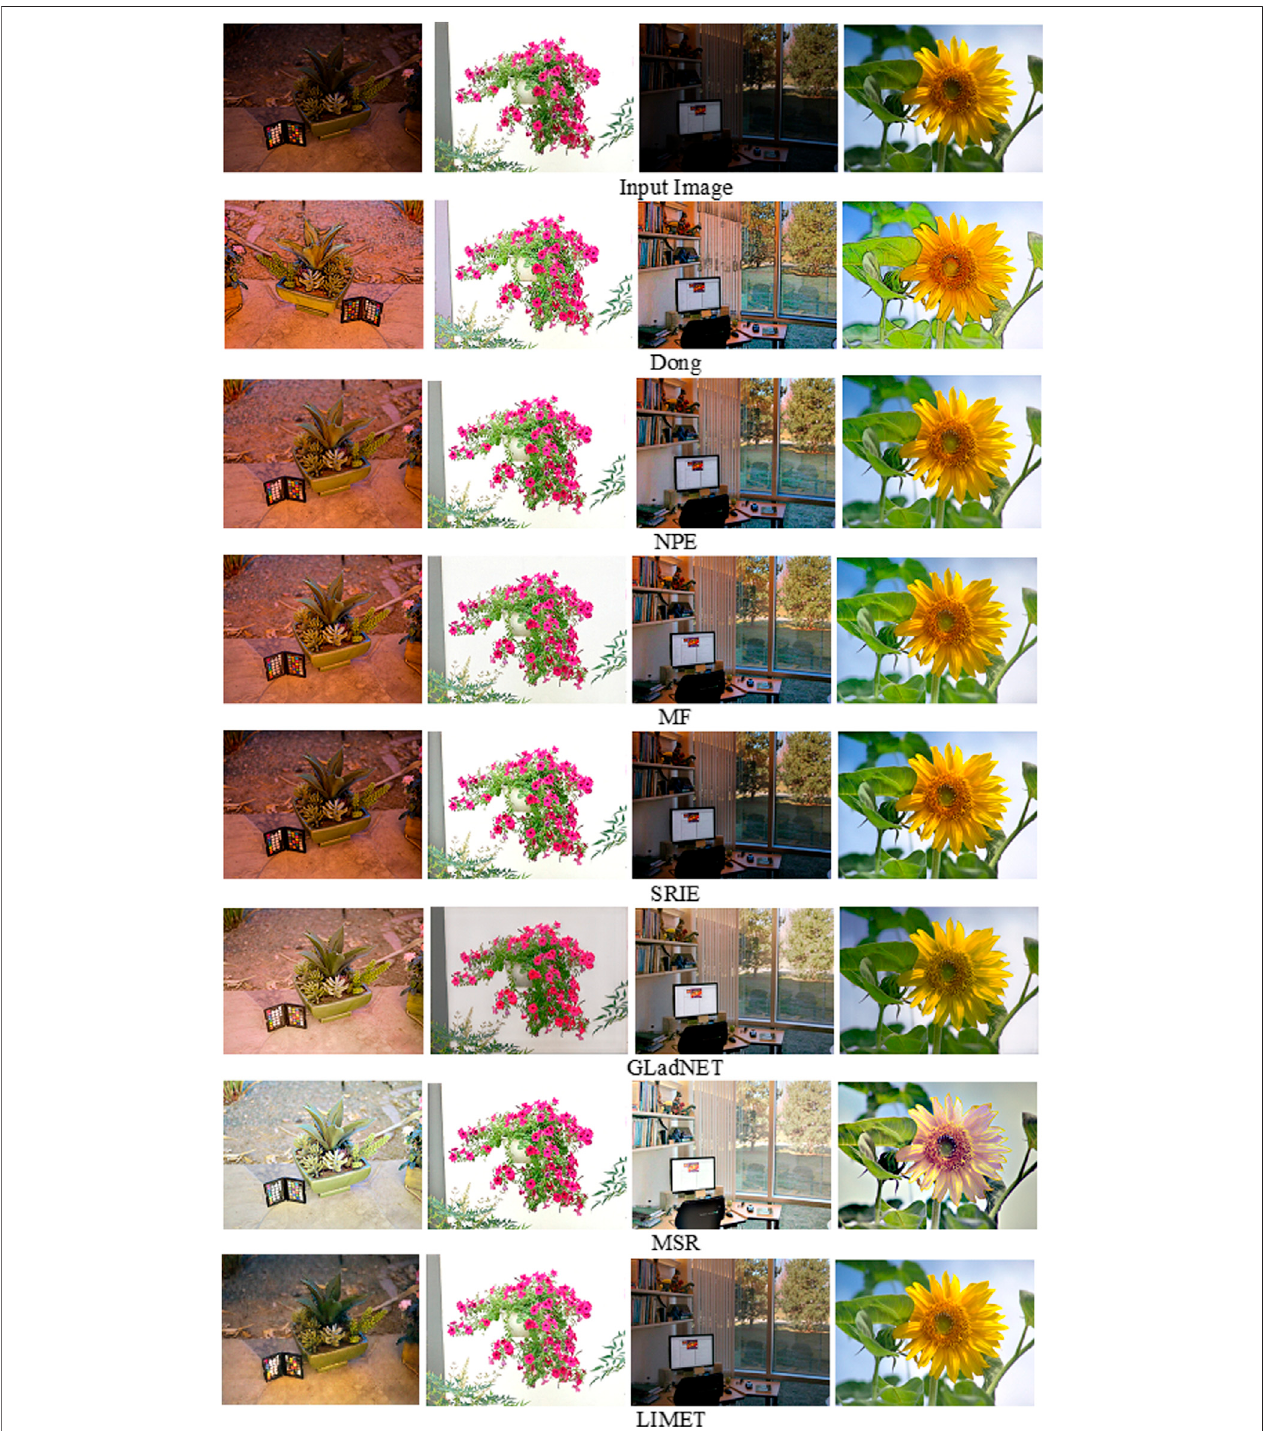
FIGURE 5 | Enhancement comparison of the proposed approach with existing approaches.